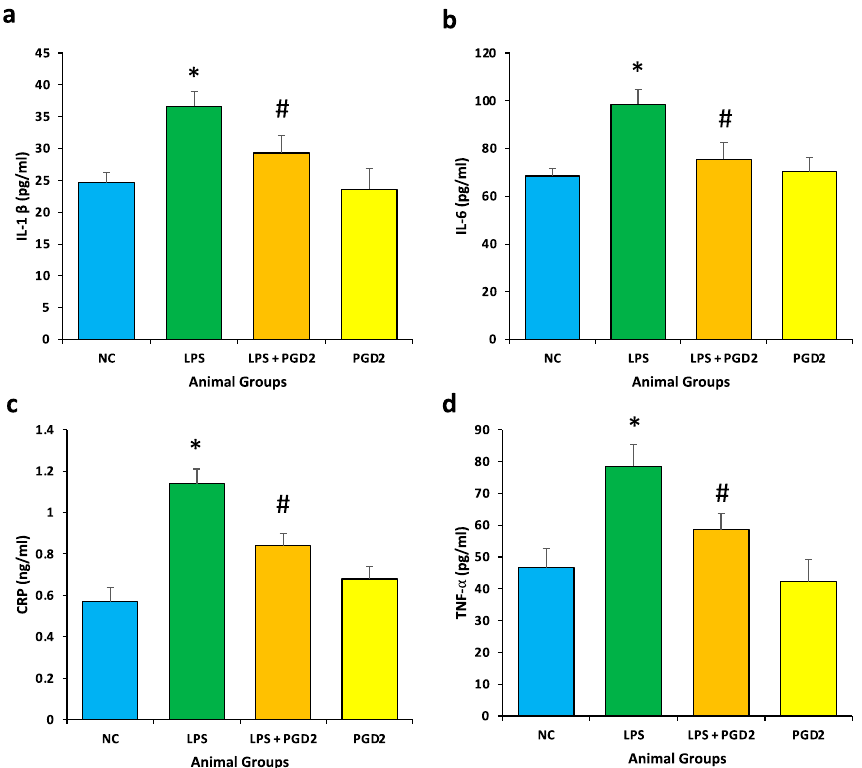
Figure 4. Proinflammatory marker levels in various groups of mice. The values represent the mean ± SEM, with 8 mice in each group. Treatment with LPS (5 mg/kg b.w.) (Group 2) enhanced IL- 1 β , IL-6, CRP, and TNF- α levels in comparison to NC animals. Management with PGD 2 (100 µ g/kg b.w.) remarkably reduced the levels of these parameters in Group 3 (LPS + PGD 2 ) animals ( p <